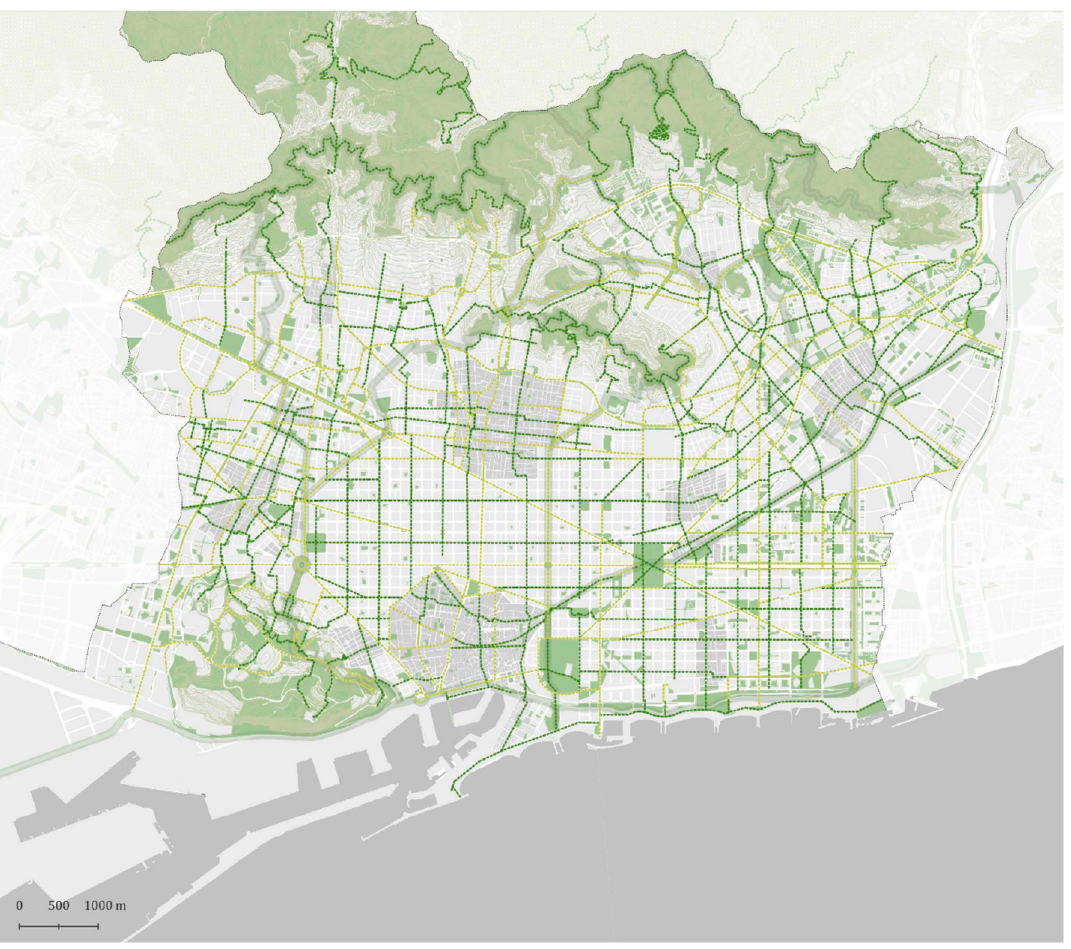
Figure 1. Green spaces in the city of Barcelona and green axes (dotted green lines) foreseen in the Barcelona Superblock strategy Source: Ajuntament de Barcelona [44].